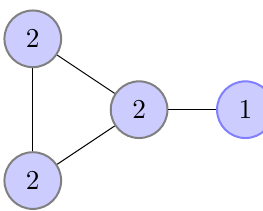
Figure 15 . The mirror quiver obtained after performing the Coulomb branch (cid:13)ow from (cid:12)gure 12 described in the main text. Nodes and lines are de(cid:12)ned as in (cid:12)gure 11.